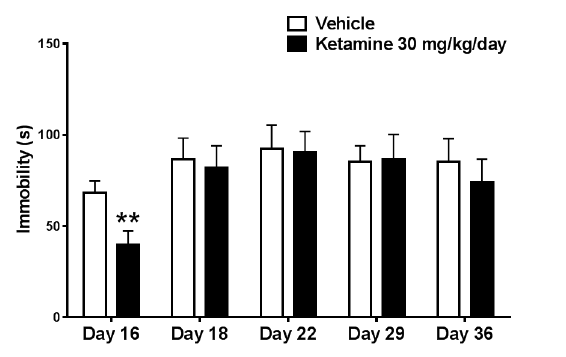
Figure 4 - Anti-immobility effect of ketamine 30 mg/kg/day i.p. (14 days) is not persistent. Results are expressed as mean ± S.E.M (n = 12). ** p < 0.01 on Student’s t test.